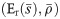
Bimodality for experimental data from neuroscientific literature.Mean activities and correlations (Er(s¯),ρ¯) inferred from experimental data reported in Cohen & Kohn [37, Table 1], plotted upon the curves separating bimodal from unimodal maximum-entropy distributions of Fig 5A. The plot suggests that typical experimental neural recordings of 250 neurons and above are likely to lead to bimodal maximum-entropy pairwise distributions.